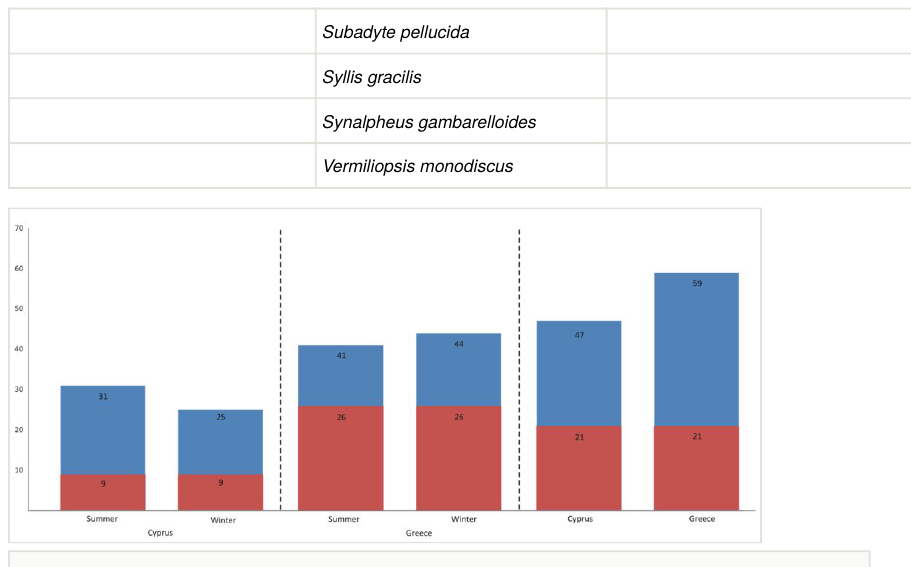
Figure 11. Total number of species (in blue) and common number of species (in red) for both locations and both sampling